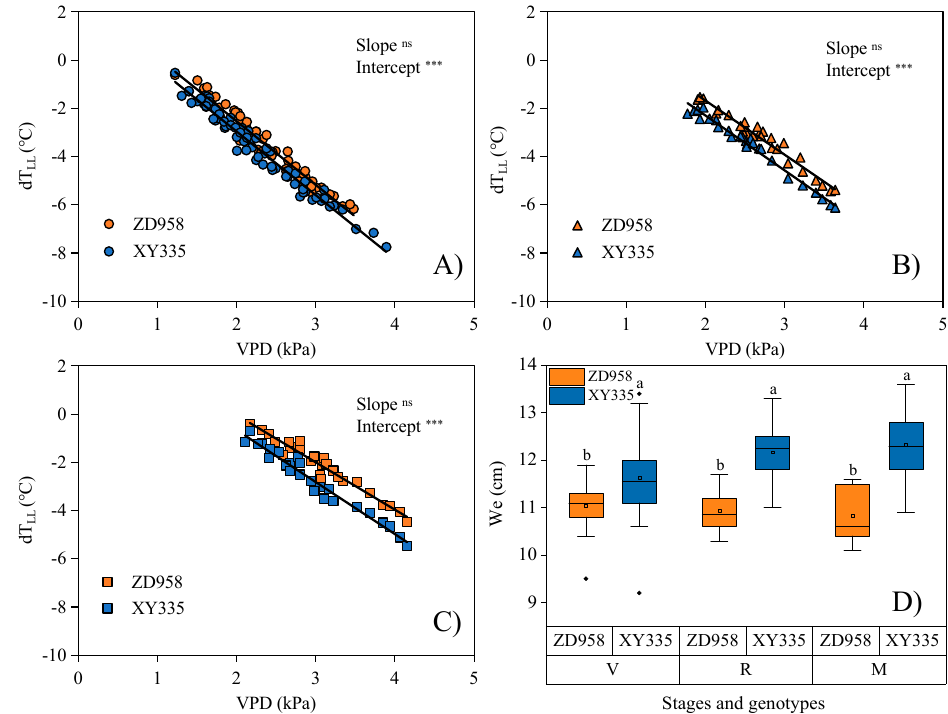
Figure 4. The relationships between lower limit of canopy-air temperature difference (dT LL ) and vapor pressure deficit (VPD) for two maize genotypes (ZD958 and XY335) during ( A ) the late vegetative (V), ( B ) reproductive (R), and ( C ) maturation stages (M), respectively. ( D ) Average effective leaf width (W e ) is presented for two genotypes during three growth stages. The slopes and intercepts between two genotypes are compared by the ANOVA test during the V, R, and M stages, respectively. For the box plot, the lower and upper bounds correspond to the first and third quartiles (interquartile range, IQR), the horizontal lines inside the boxes are the medians, the upper/lower whisker extends from the bound to the largest/smallest value no further than 1.5 × IQR from the bounds, and data beyond the end of the whiskers are plotted individually. The differences in W e between two genotypes are analyzed by one-way ANOVA during three growth stages. Different letters denote significant differences ( p < 0.05) by a Tukey’s posthoc test for means comparison. ns, no significant difference; ***, p < 0.001.